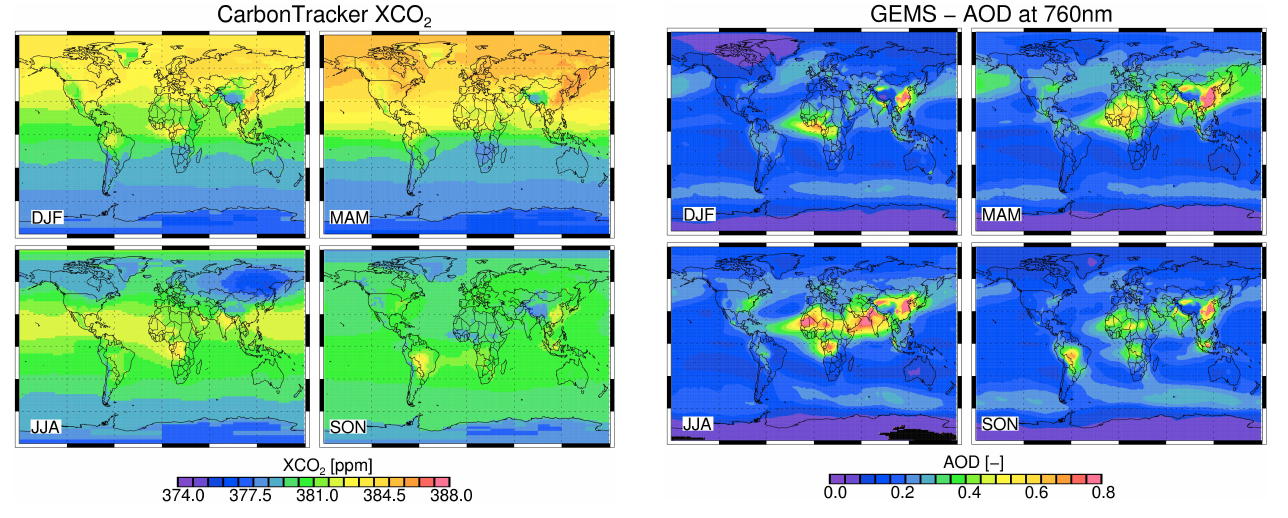
Fig. 3. Seasonal averages of NOAA’s CarbonTracker XCO 2 for 2004–2008, modified to take SCIAMACHY’s CO 2 column aver- aging kernels into account.